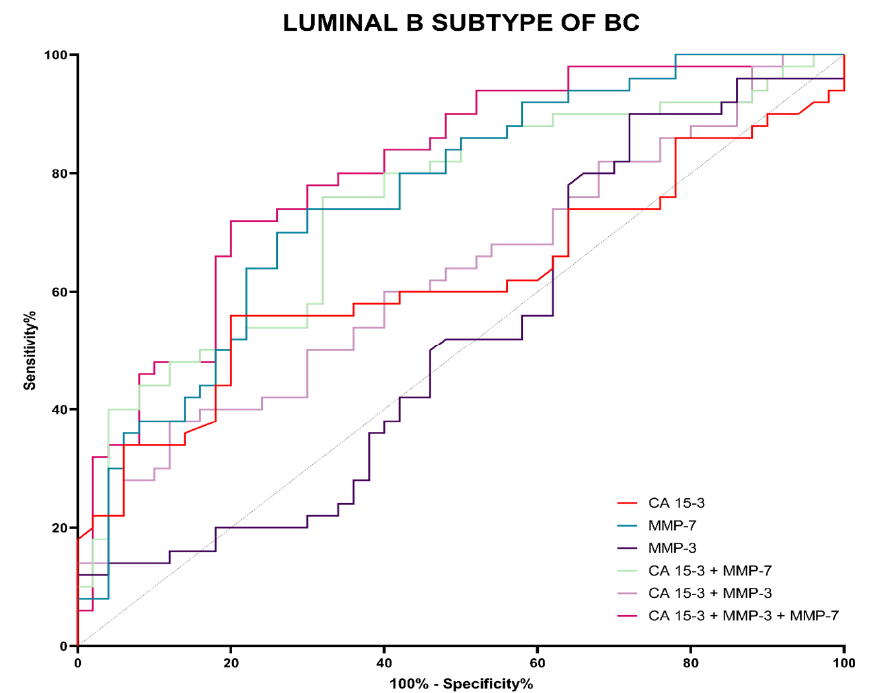
Figure 11. Evaluation of diagnostic power based on the area under the ROC curve (AUC) in Luminal B subtype of BC.